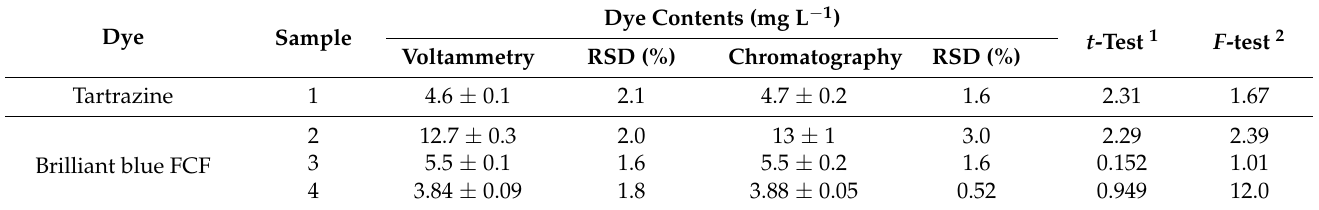
Table 6. Quantification of tartrazine and brilliant blue FCF in soft and isotonic sports drinks ( p = 0.95). Dye Sample